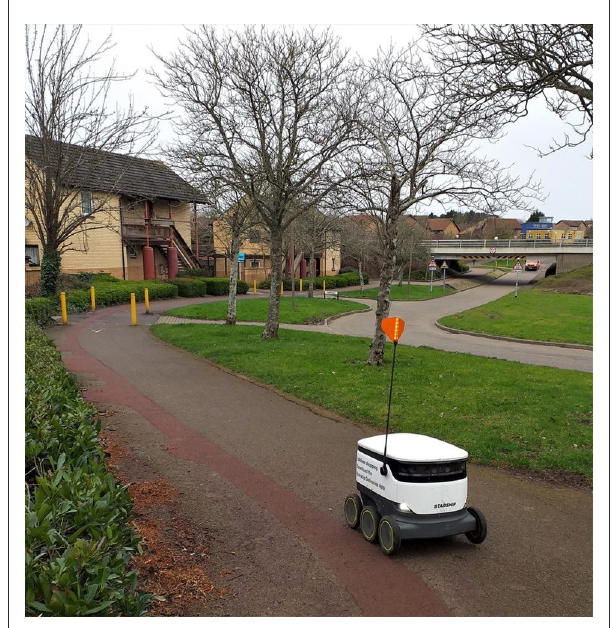
FIGURE1 Starship robot in MK, traveling along a segregated path for pedestrians and cyclists colloquially known as a